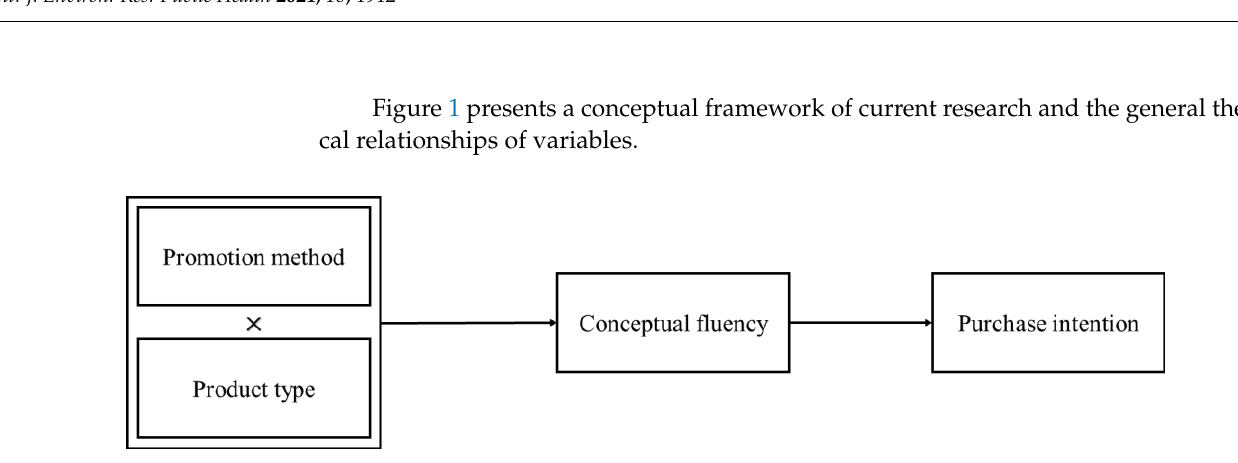
Figure 1. Conceptual model.